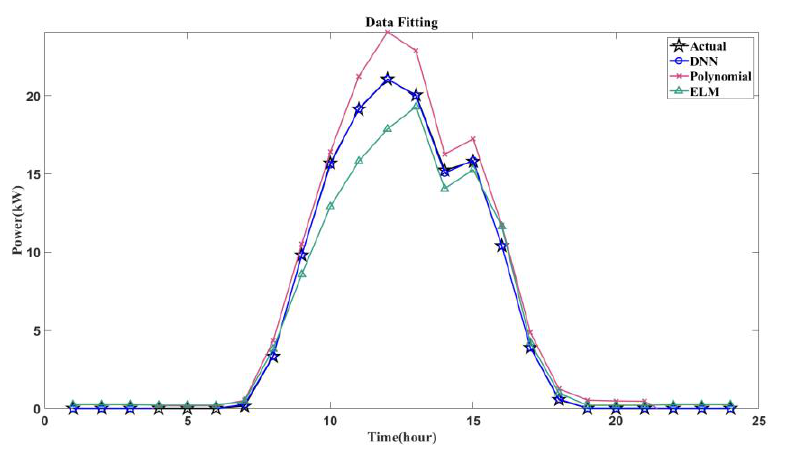
Table 13. Execution times and training runtimes of different forecasting models.